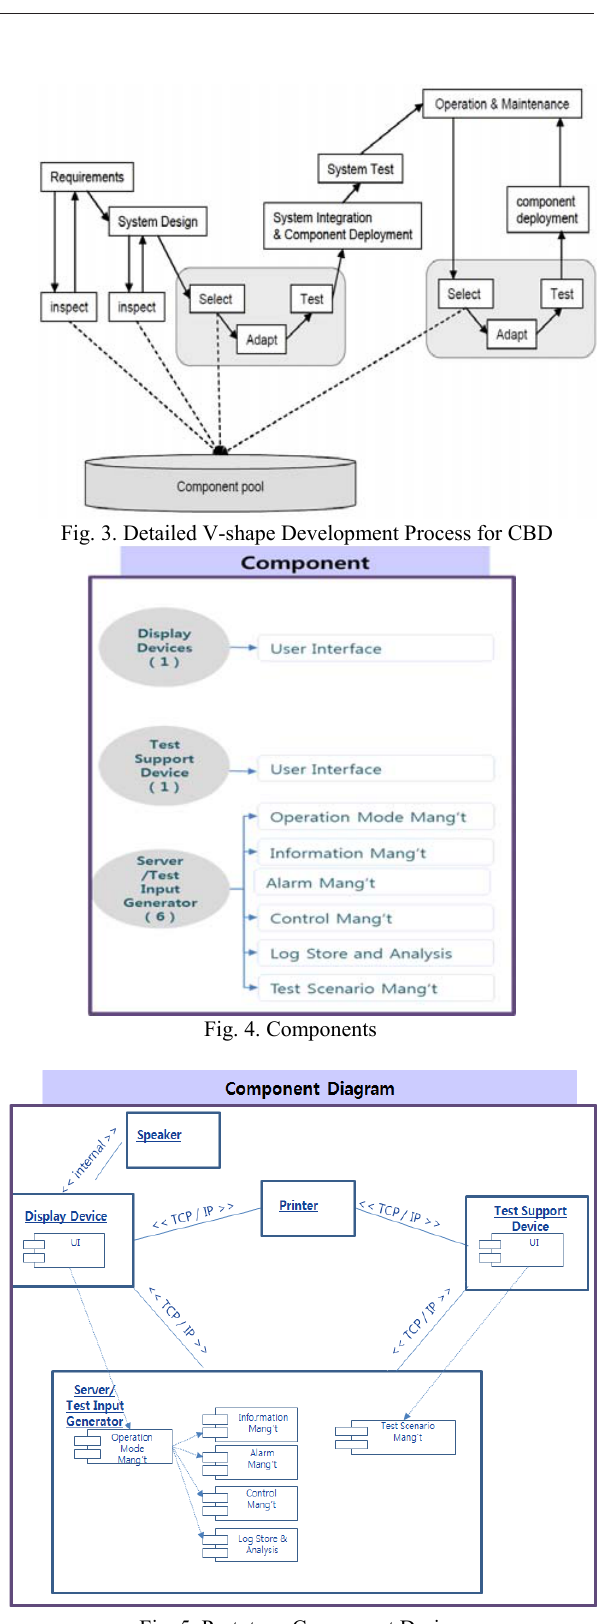
Fig. 5. Prototype Component